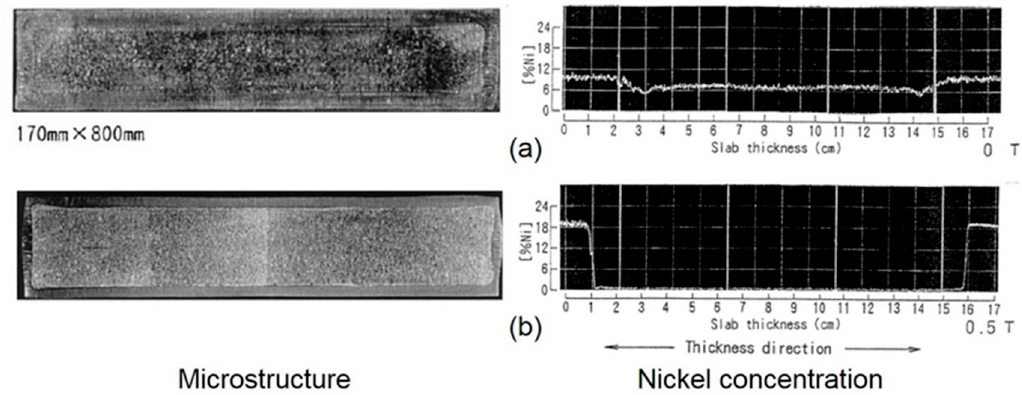
Figure 29. Comparison of microstructure and nickel distribution in the clad steel slabs ( a ) without and ( b ) with LMF